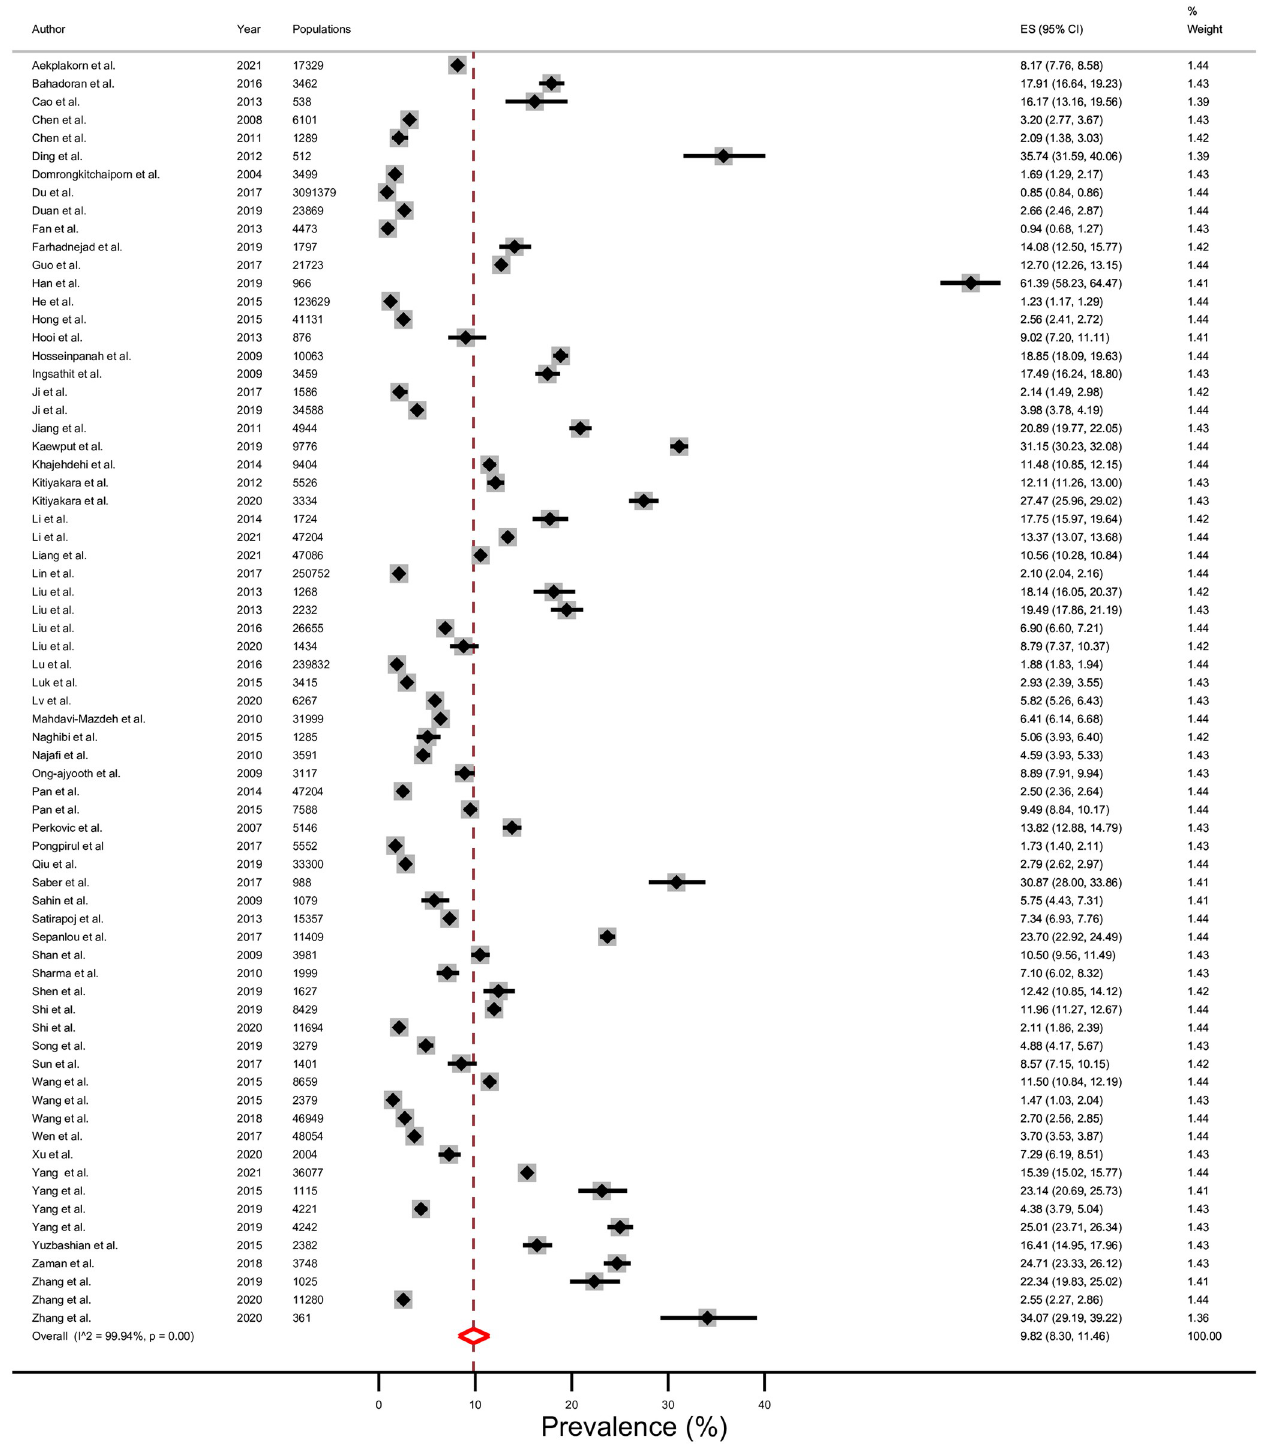
Fig 4. Prevalence of chronic kidney disease (CKD) stages 3–5 in upper-middle income countries using a random-effects model.